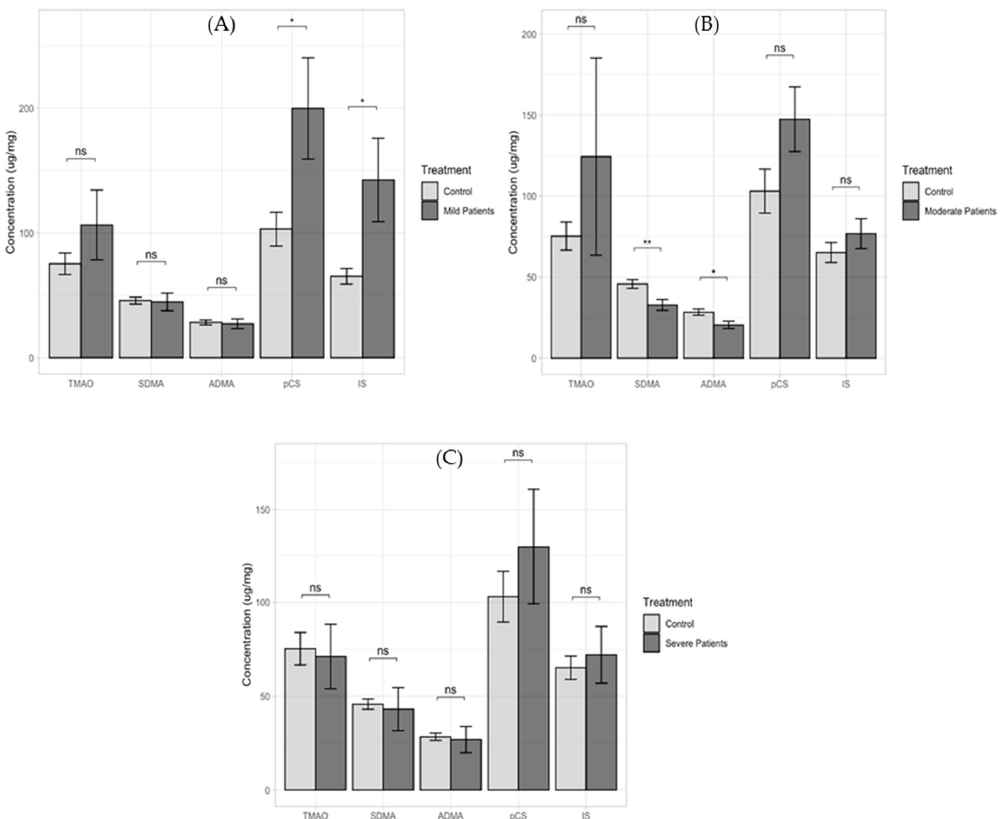
Figure 3. Comparison of levels of TMAO, SDMA, ADMA, pCS, and IS ( A ) in a group of mild-clas- si fi ed patients vs. the control group (71 vs. 48); ( B ) in a group of moderate-classi fi ed patients vs. the control group (60 vs. 48); and ( C ) in a group of severe-classi fi ed patients vs. the control group (12 vs. 48). ns—not signi fi cant di ff erence; *—statistically signi fi cant, with p < 0.05; **—statistically sig- ni fi cant, with p < 0.001.